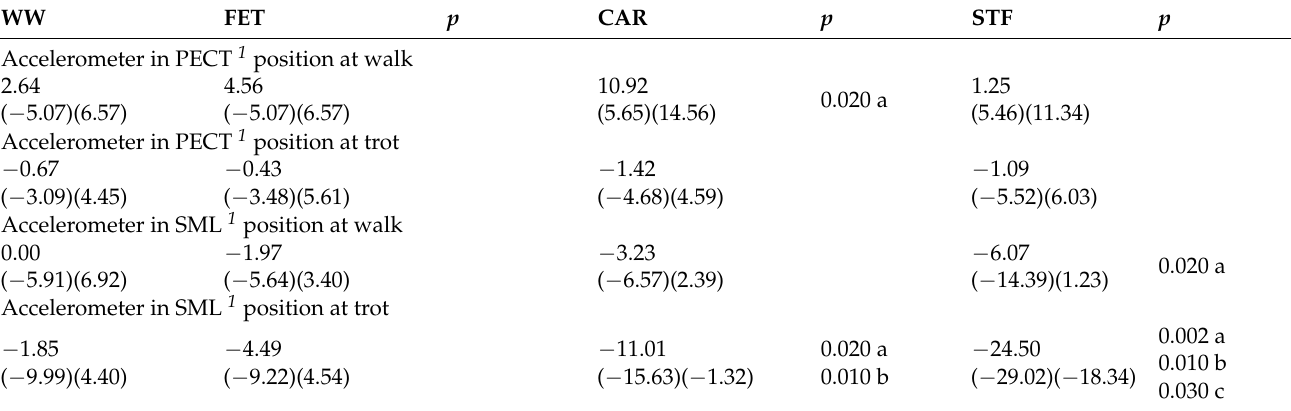
Table 2. Median and quartiles of the percent of change from baseline of the stride regularity, mea- sured on a track, at four different water depths, at walk and at trot and with the accelerometer fixed in two different positions. WW: treadmill without water; FET: water at the level of the fetlock; CAR: water at the level of the carpus; STF: water at the level of the stifle. 1 Position of the accelerome- ter: pectoral position (PECT) and sacrum midline position (SML). a: significant differences with